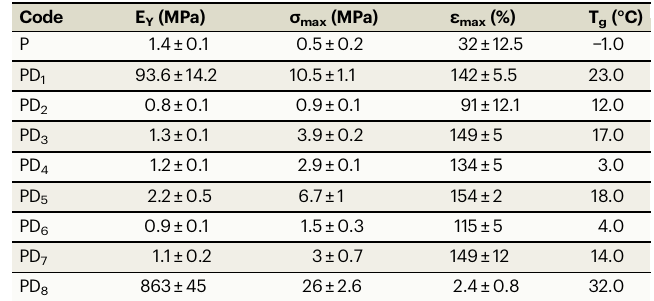
Table 2 | Glass transition temperature and Mechanical properties of P and PD n Code